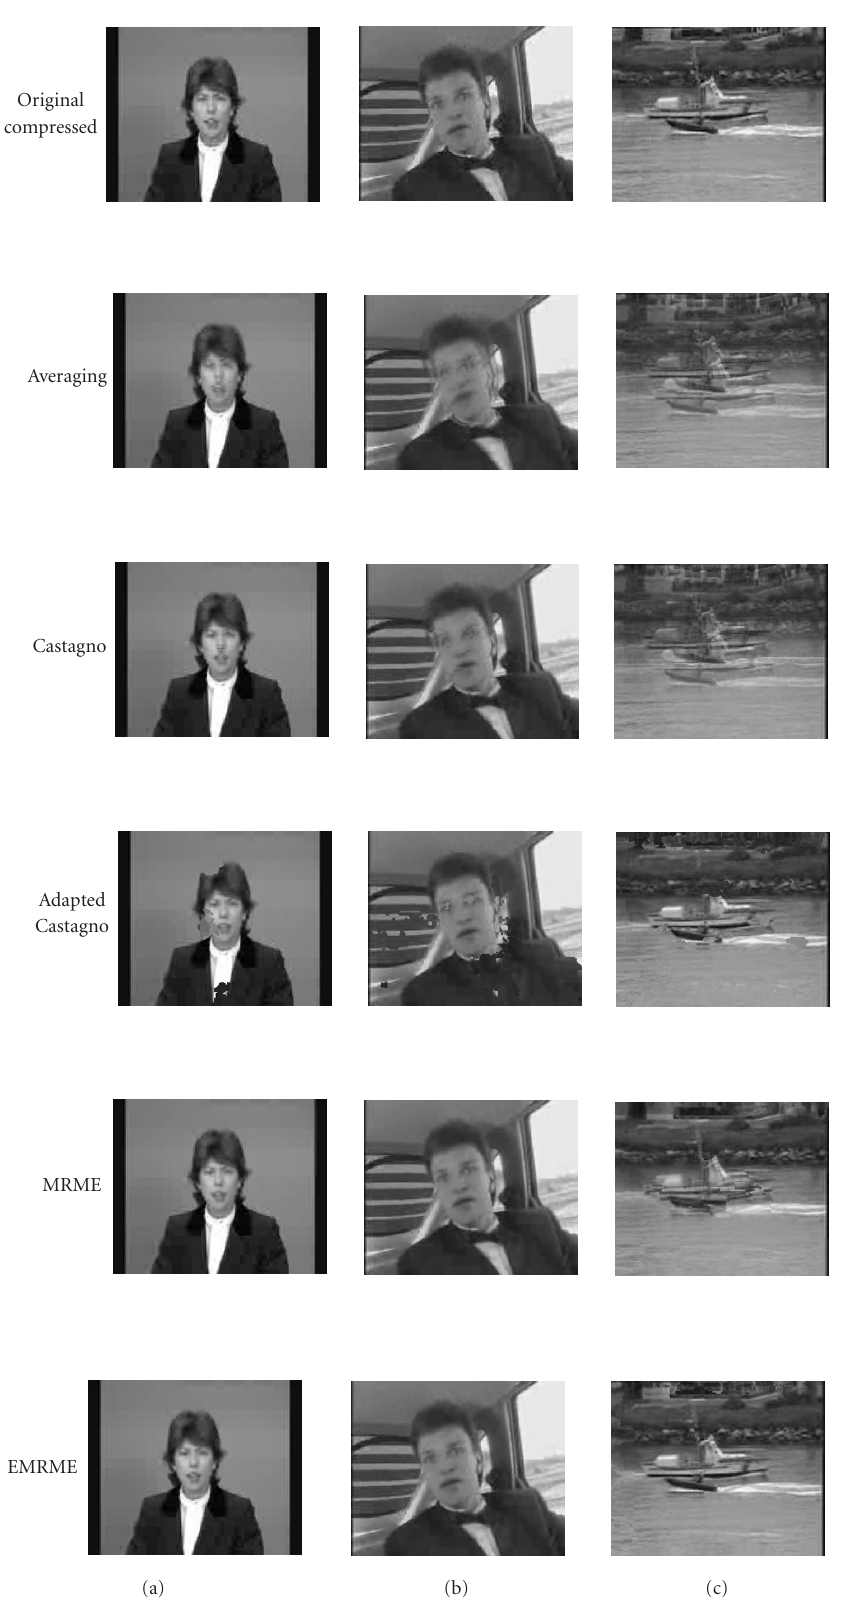
Figure 4: Typical results for interpolation on QCIF image sequences. (a) Claire. (b) Carphone. (c)